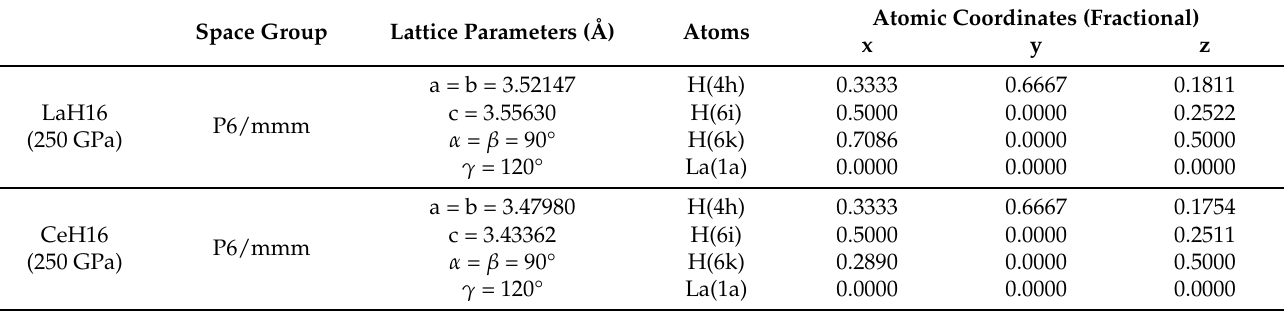
Table A1. Calculated structural parameters of the La–H and Ce–H